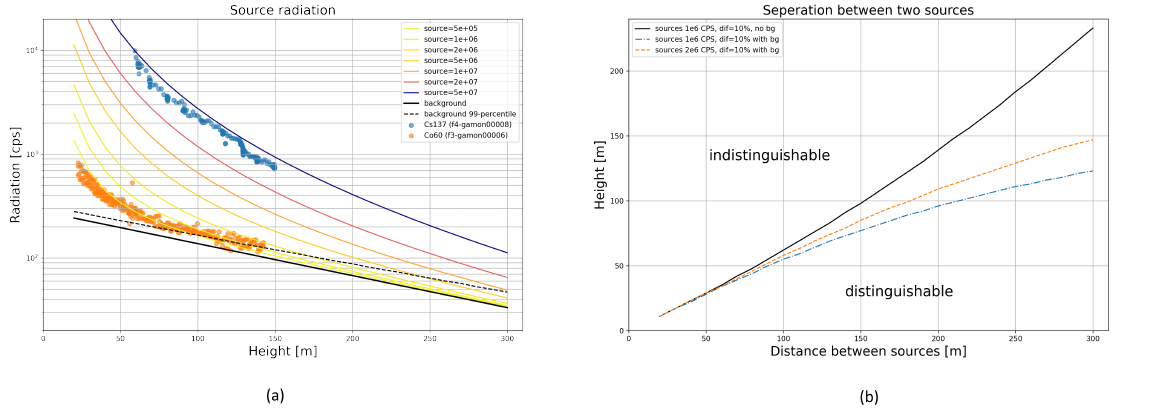
Figure 10. Detection limit by flight altitude with measurements from two flights up to 150 m above ground ( a ) and source separation limits ( b